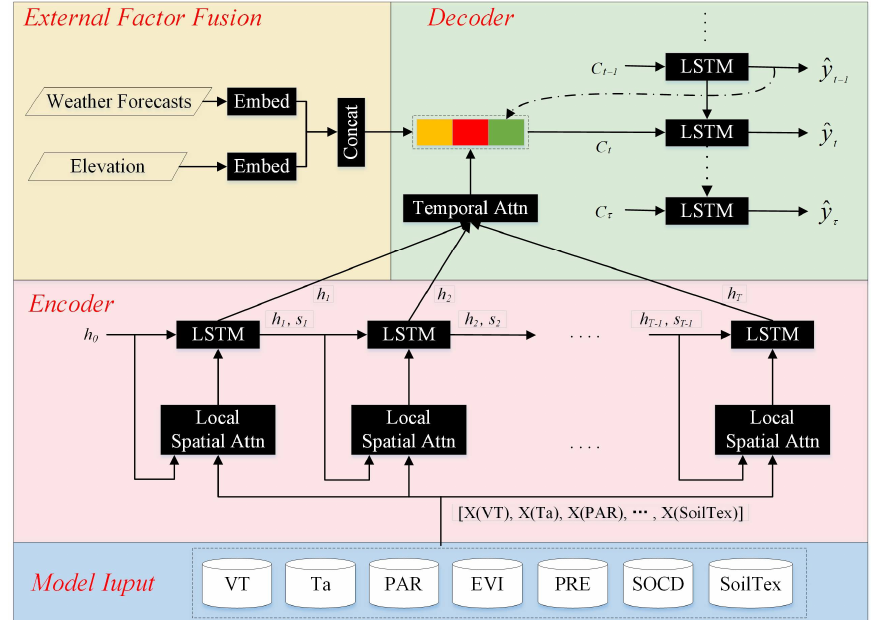
Figure 2. The structure of Geoman adapted from Liang et al. [44]. LSTM: long short-term memory networks. Attn: attention. Concat: concatenation layer. ˆ y t : the predicted value at time t . C t : the context vectors at time t . h 0 : the initial state of encoder. VT: vegetation type. Ta: temperature. PAR: photosynthetically active radiation. EVI: enhanced vegetation index. PRE: precipitation. SOCD: soil organic carbon density. SoilTex: soil texture.